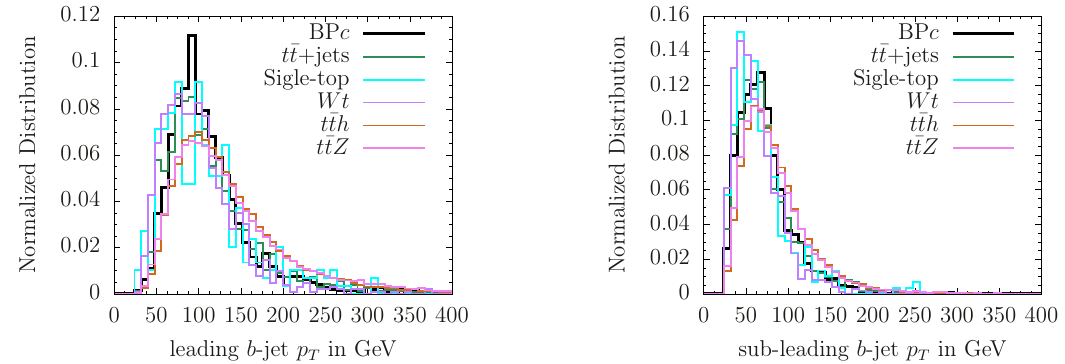
Figure 7 . The normalized p T distributions of the leading and subleading b -jets for the signal (BP c ) and the leading backgrounds.